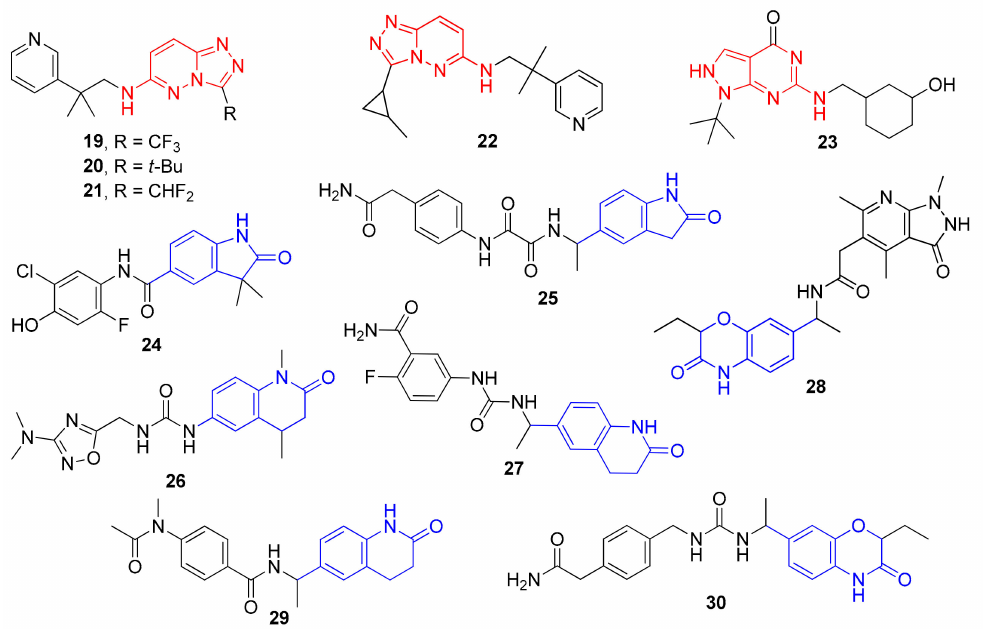
Figure 5. Two structural series identified after the thermal shift assay.